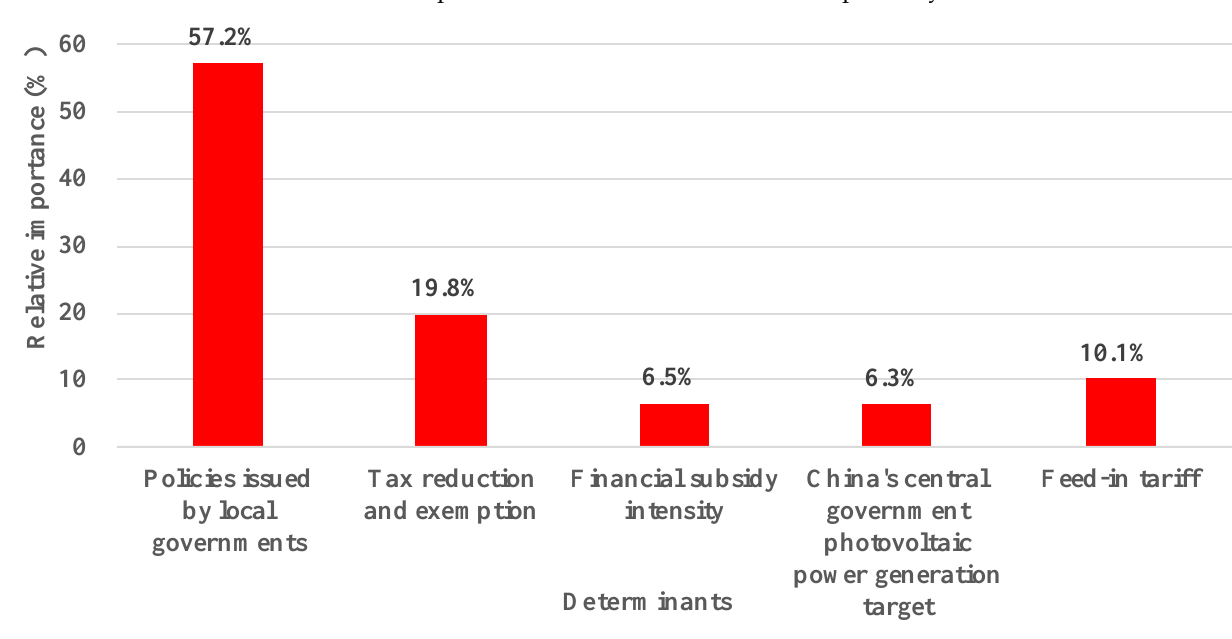
Figure 7. Relative importance of government determinants.